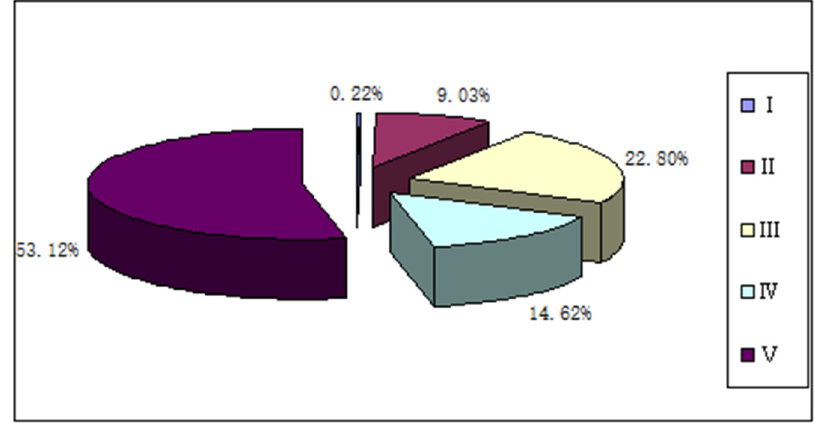
Figure 4. Pie chart of the proportion of water to area for each class.